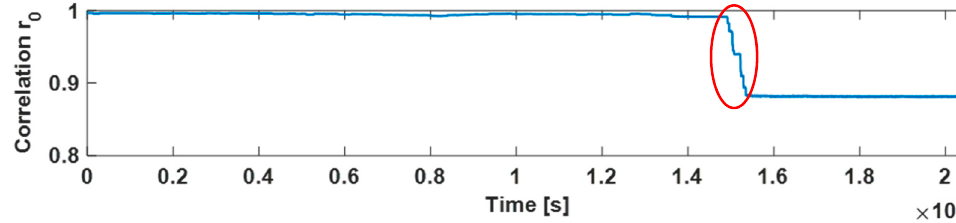
Figure 5. Correlations r 0 with a null water flow condition for both the water meters considered.